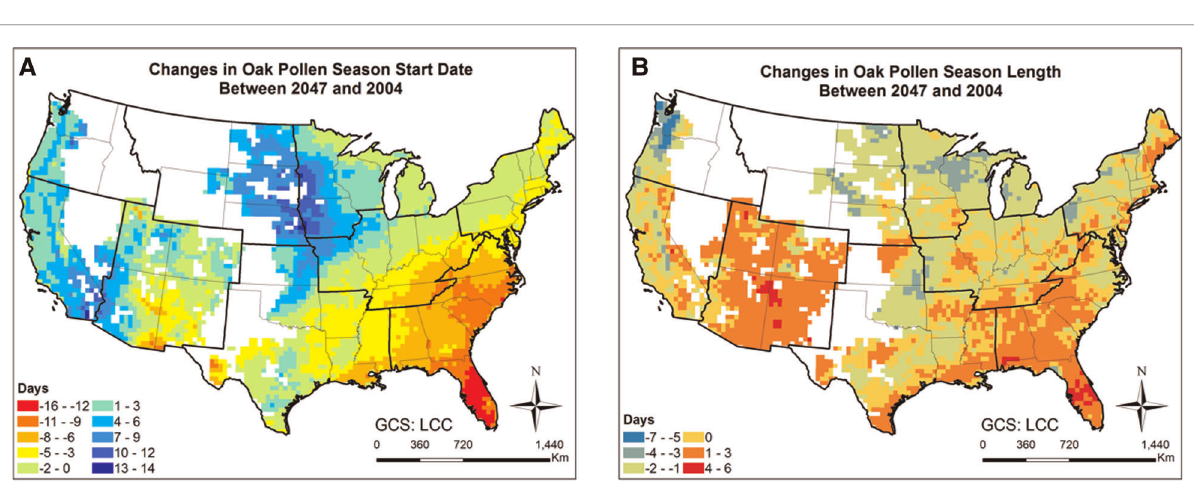
FIGURE 8 Changes in oak pollen season between 2047 and 2004 estimated for the RCP8.5 climate change scenario using the CMAQ-Pollen model. ( A ) Changes in oak pollen season start date between 2047 and 2004; ( B ) Changes in oak pollen season length between 2047 and 2004. Data were mapped only on cells in which the area coverage of oak trees is greater than